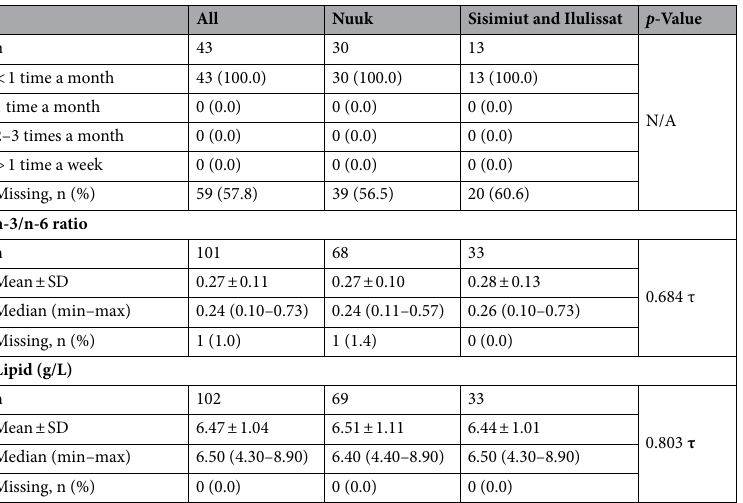
Table 1. Maternal characteristics: pregnant Greenlandic women in the ACCEPT cohort 2013–2015. N total number of participants, n number of participants with information on the variable, τ: p -Value was calculated with student T-test on ln-transformed data, χ : p -Value was calculated with Chi-square test, Bold text and * = Significant ( p ≤ 0.050), N/A: Test not